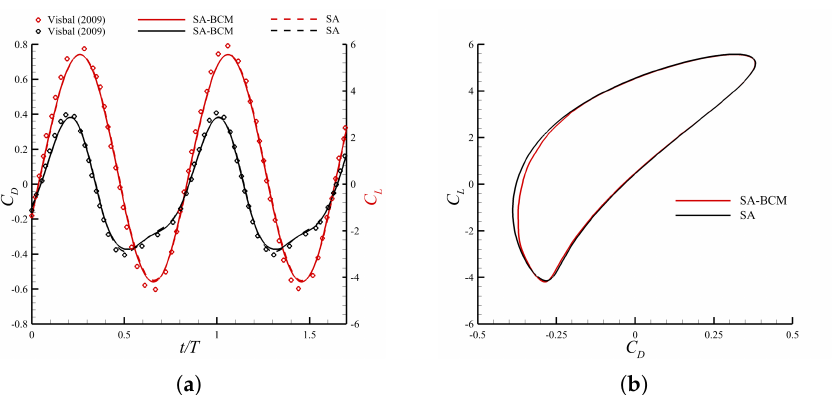
Figure 8. ( a ) Time behaviour of drag and lift coefficients for SA, SA − BCM, and scale − resolving 3D model obtained via image digitization of data in [11]. ( b ) Phase plane representation of drag and lift coefficients for SA and SA − BCM